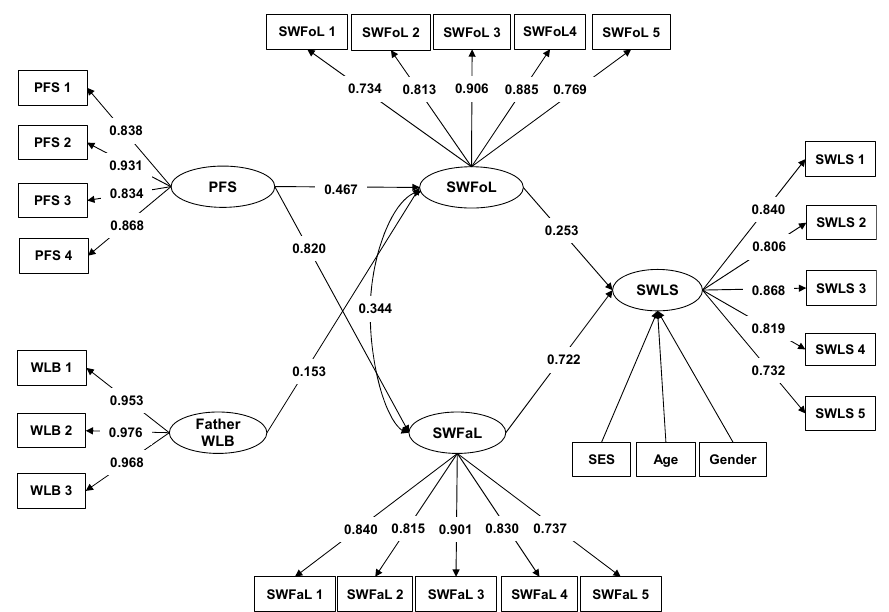
Figure 2. Path diagram of the model that explains the relationships between Perceived Family Support (PFS), fathers’ Work-life Balance (Father WLB) and Satisfaction with Family Life (SWFaL) and Satisfaction with Food-related Life (SWFoL) and between SWFoL, SWFaL and Satisfaction with Life Scale (SWLS) in adolescents. SES: Socioeconomic status. Only significant path coefficients are shown ( p < 0.05). The items of each scale are shown in the Appendix A.